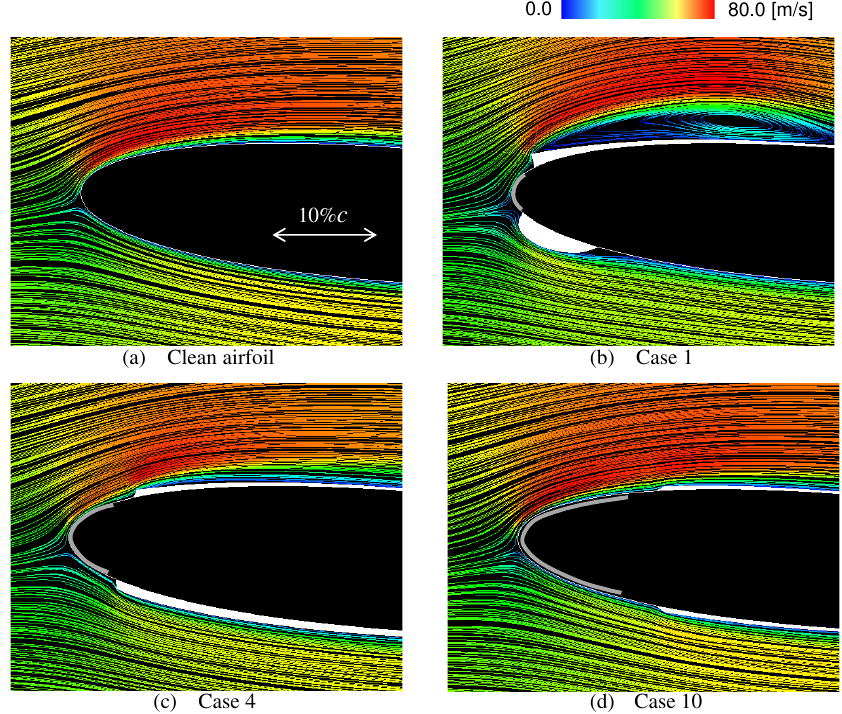
Figure 9. Streamline and icing shapes around the NACA 0012 airfoil. The color of the streamline indicates the velocity magnitude; the white and dark gray regions on the airfoil surface indicate the formed ice and heater location, respectively: ( a ) clean airfoil without icing; ( b ) Case 1; ( c ) Case 4; and, ( d ) Case